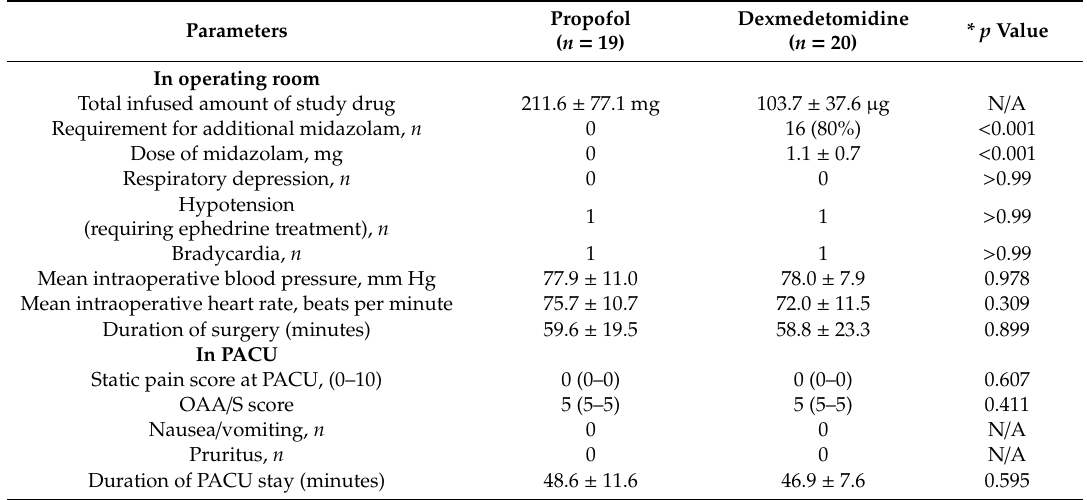
Table 2. Perioperative parameters in the propofol group and in the dexmedetomidine group. Parameters